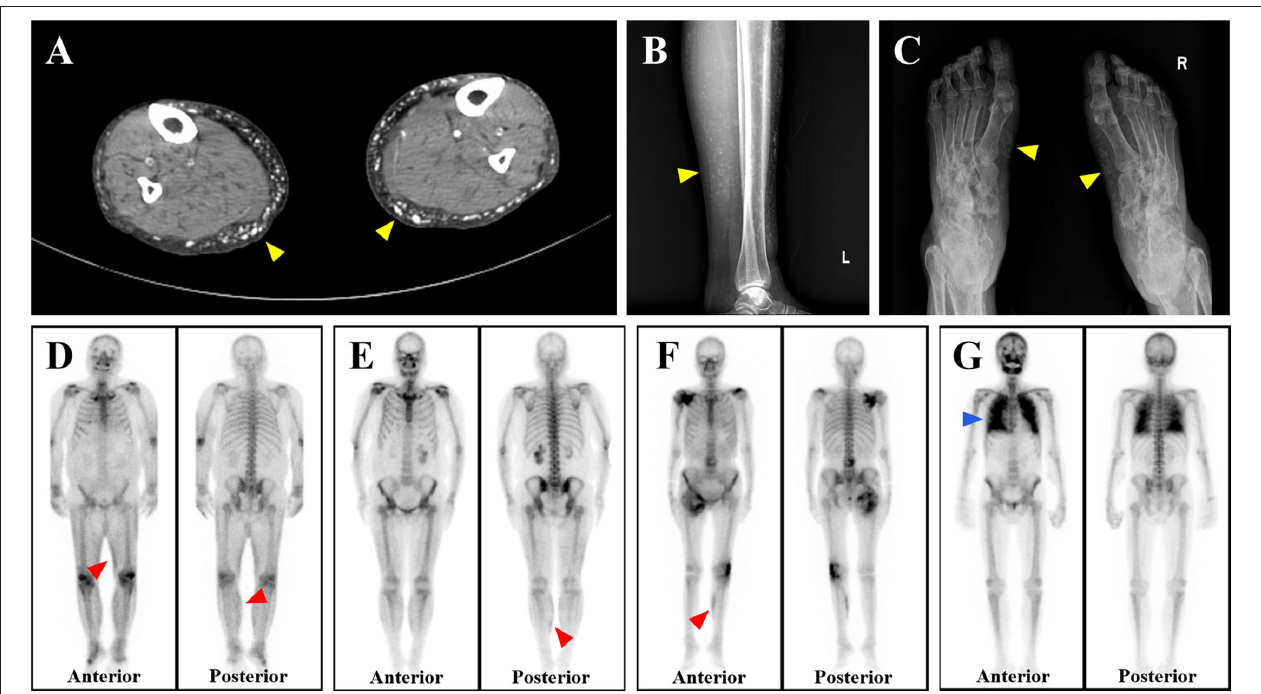
FIGURE 3 | Imaging characteristics of calciphylaxis. (A–C) Both CT and X-ray reveal subcutaneous extravascular diffuse calcium deposition of patients with calciphylaxis (yellow arrows, shown as white). (D–F) Bone scintigraphy shows the increased uptake of radiotracer by subcutaneous soft tissues of three calciphylaxis patients, especially the continuous linear abnormal radioactive concentration in the lower limbs (red arrows, shown as black). (G) Diffuse uptake enhancement is also observed with bone scintigraphy when calciphylaxis involves internal organs such as the lungs (blue